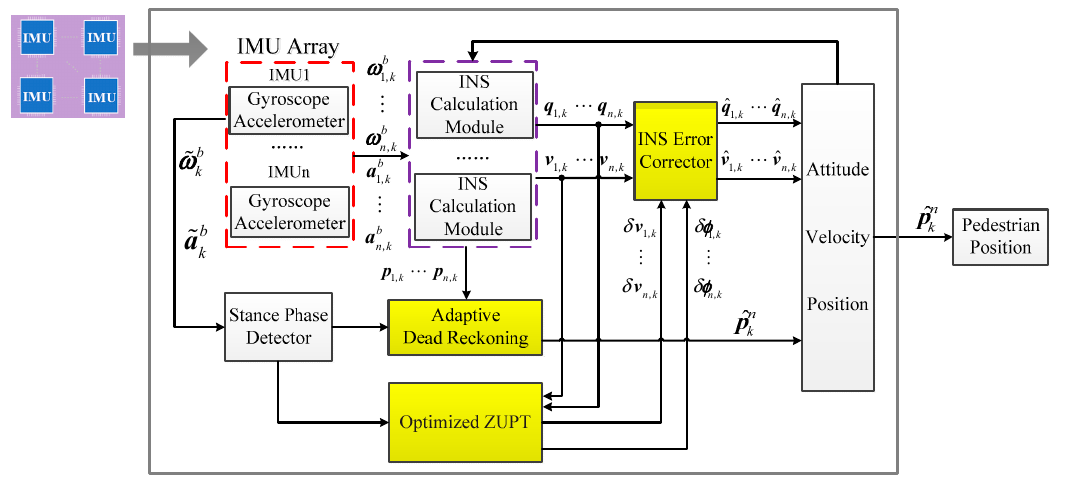
Figure 2. Block diagram of the adaptive deck reckoning (ADR)/modified zero velocity update (ZUPT) integrated algorithm.